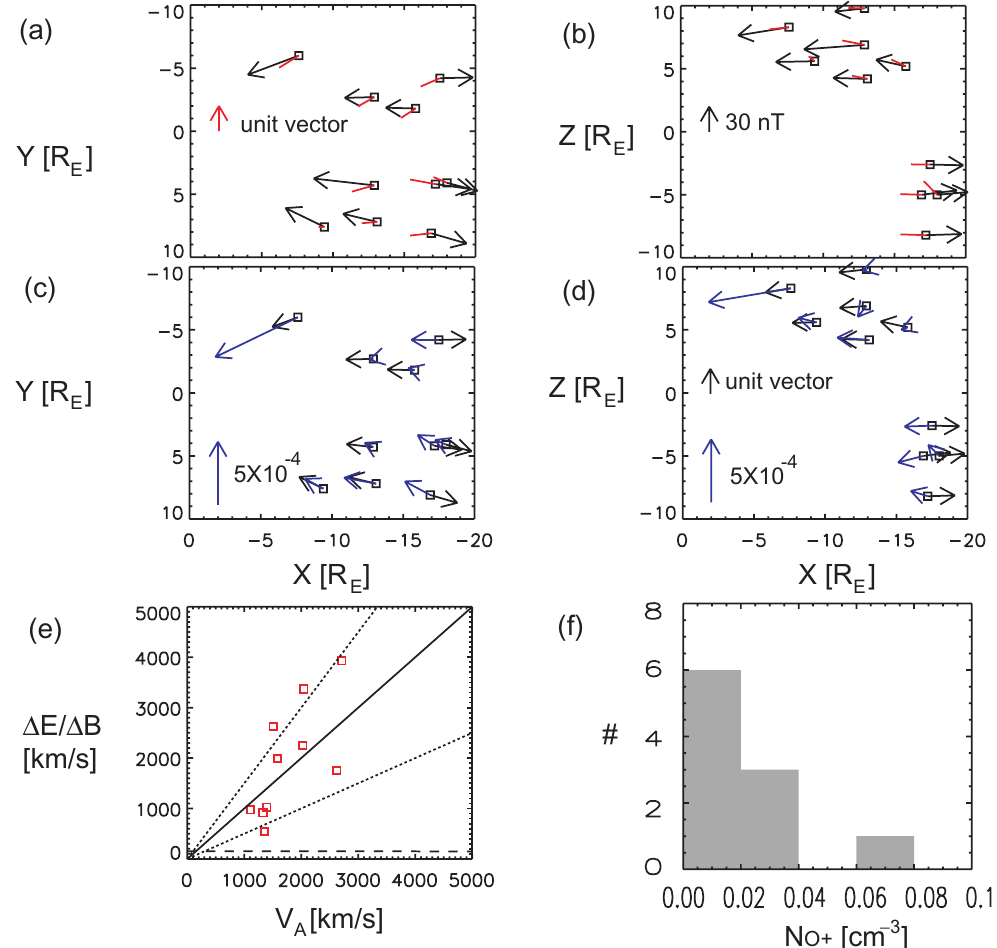
Fig. 5. The MV axis (red lines) distribution in (a) X − Y and (b) X − Z planes. Lines are adjusted to direct toward positive X since MVA includes the ambiguity about the polarity. Black arrows are the vector of background magnetic field at the point. The Poynting flux (blue arrows) are shown as vector in (c) X − Y and (d) X − Z planes. Black arrows are the unit vector of background magnetic field at the point in (c–d). (e) | 1 E ⊥ | / | 1 B ⊥ | plotted against local Alfv´en velocity. Solid lines mark the range of ± 50% values of V A . Horizontal dashed line